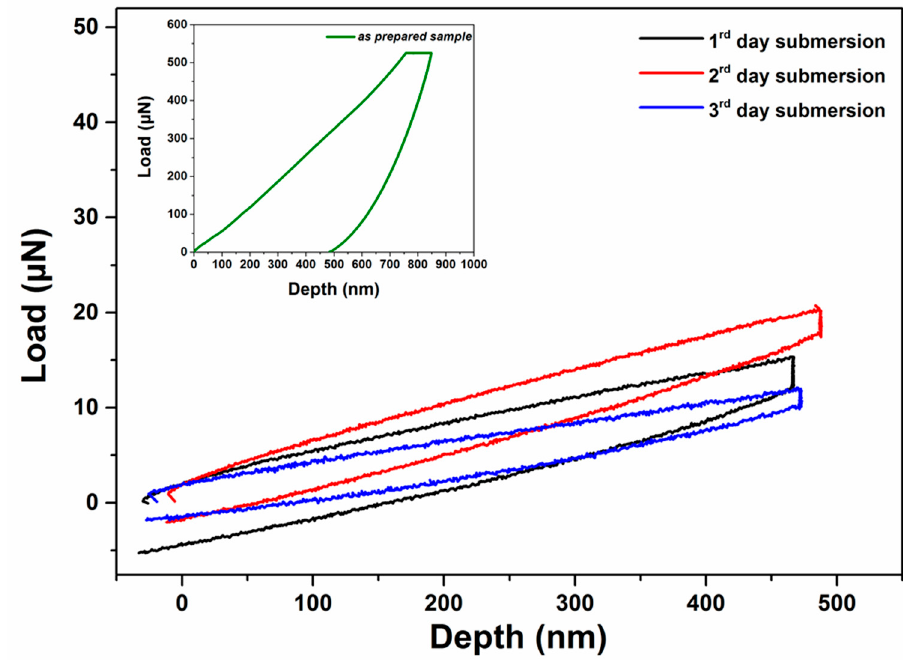
Figure 11. Load-unload curves for the CS- g -PCL sample after submersion for 1, 2, and 3 days in α -MEM at 25 °C. The inset shows the load-unload curve for the as-prepared sample.